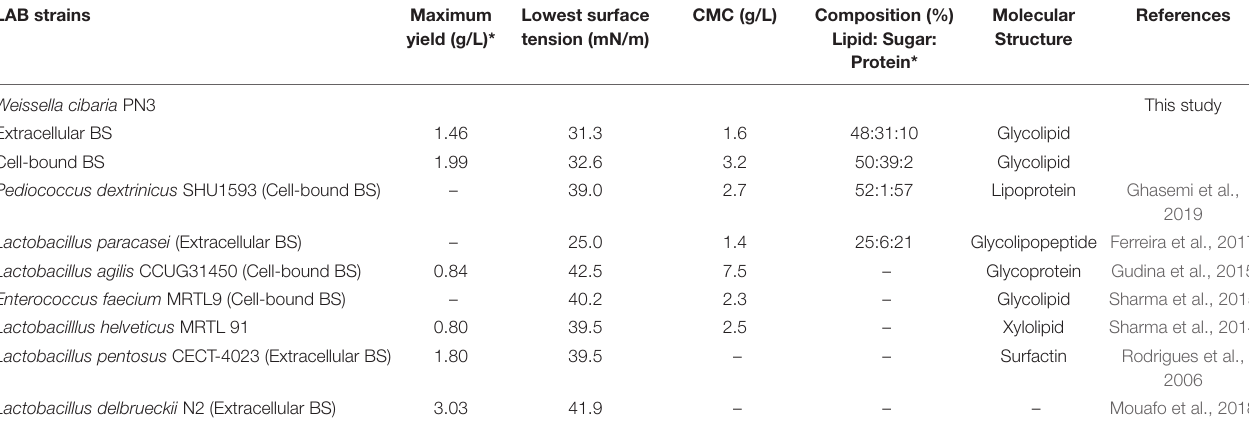
TABLE 1 | Comparison of the yield and characteristics of biosurfactants from Weissella cibaria PN3 with those from other LAB strains in a single production cycle. LAB strains Maximum